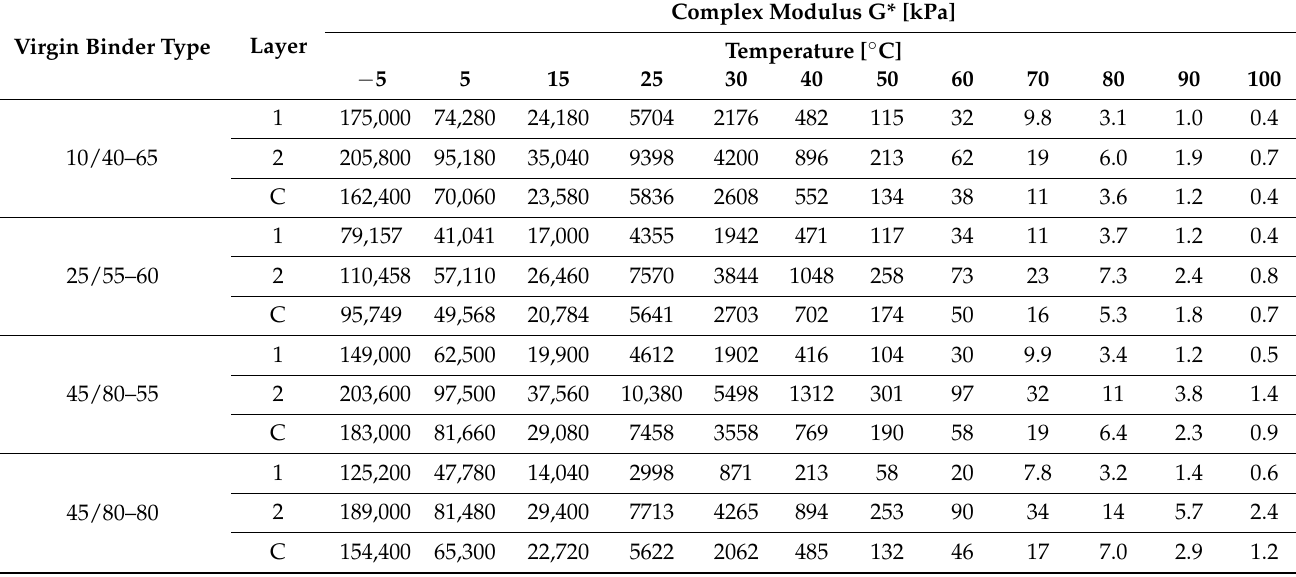
Table 5. Complex shear modulus G* of the PMBs and HIMA binders as a virgin